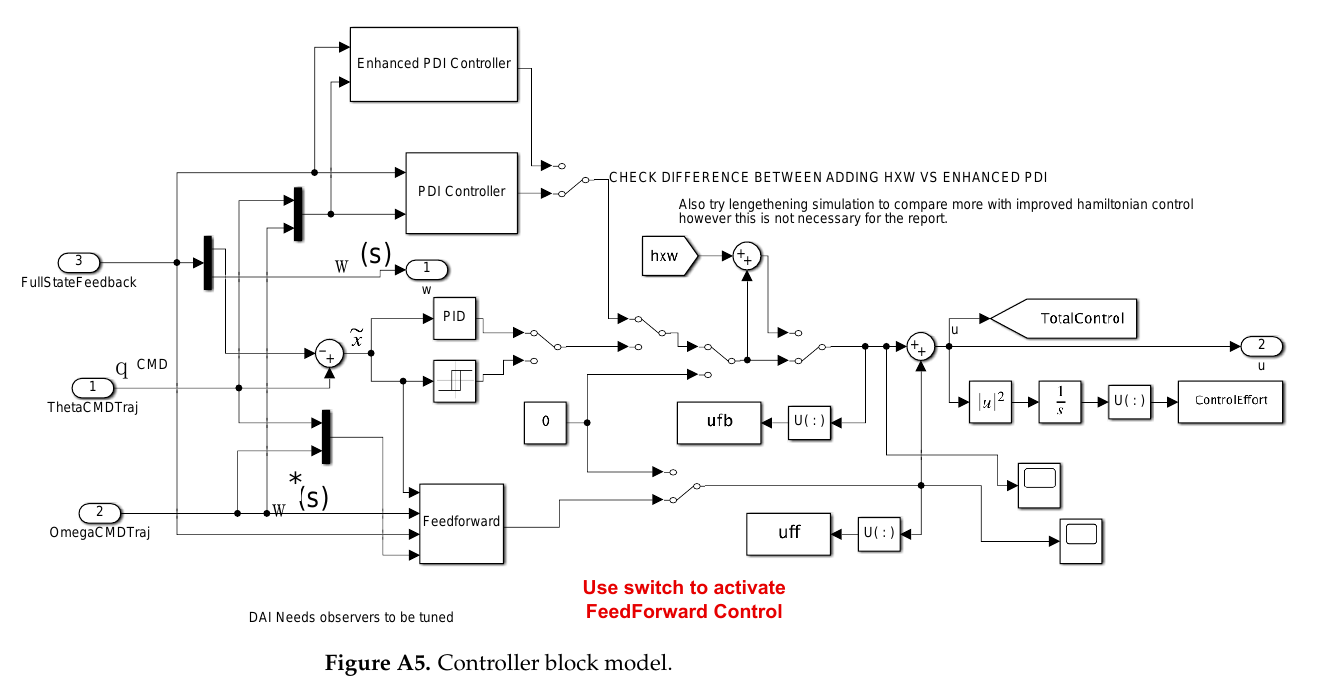
Figure A5. Controller block model.